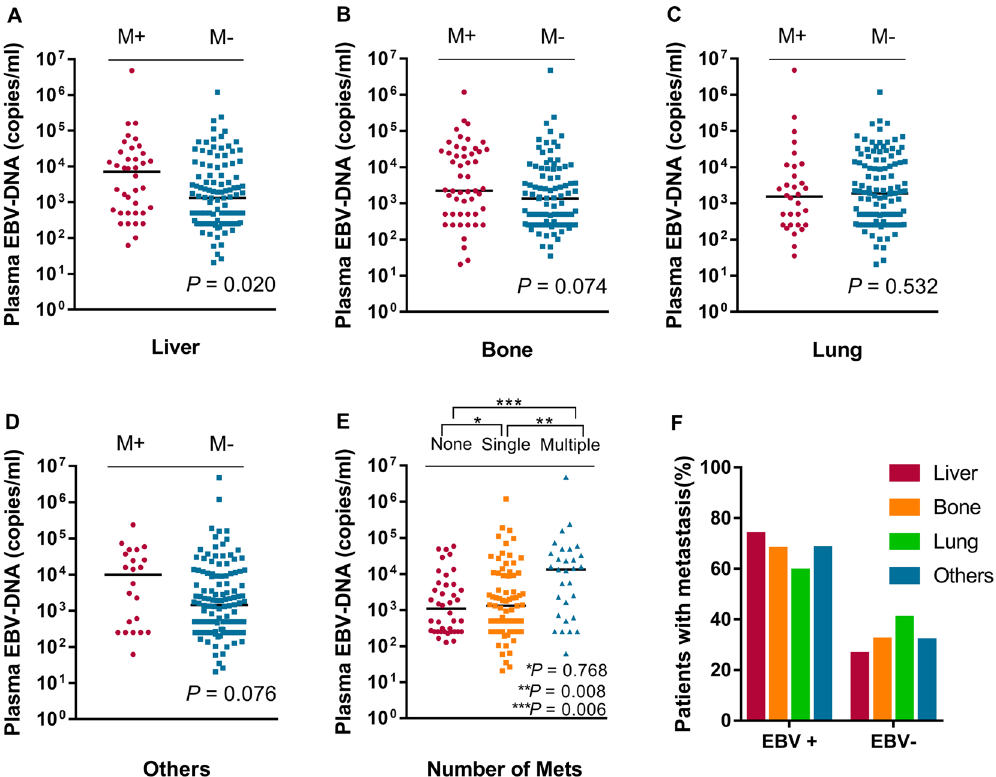
Figure 2. Comparison of EBV DNA load in patients with NPC according to different metastatic sites and the number of organ metastases. ( A – D ) Plasma EBV DNA levels of patients with NPC with or without liver ( A ), bone ( B ), lung ( C ), and other organ metastasis ( D ). ( E ) Plasma EBV DNA levels of patients with NPC according to the number of metastasis. ( F ) Pattern of organs metastasis according to the different EBV infection status. M,